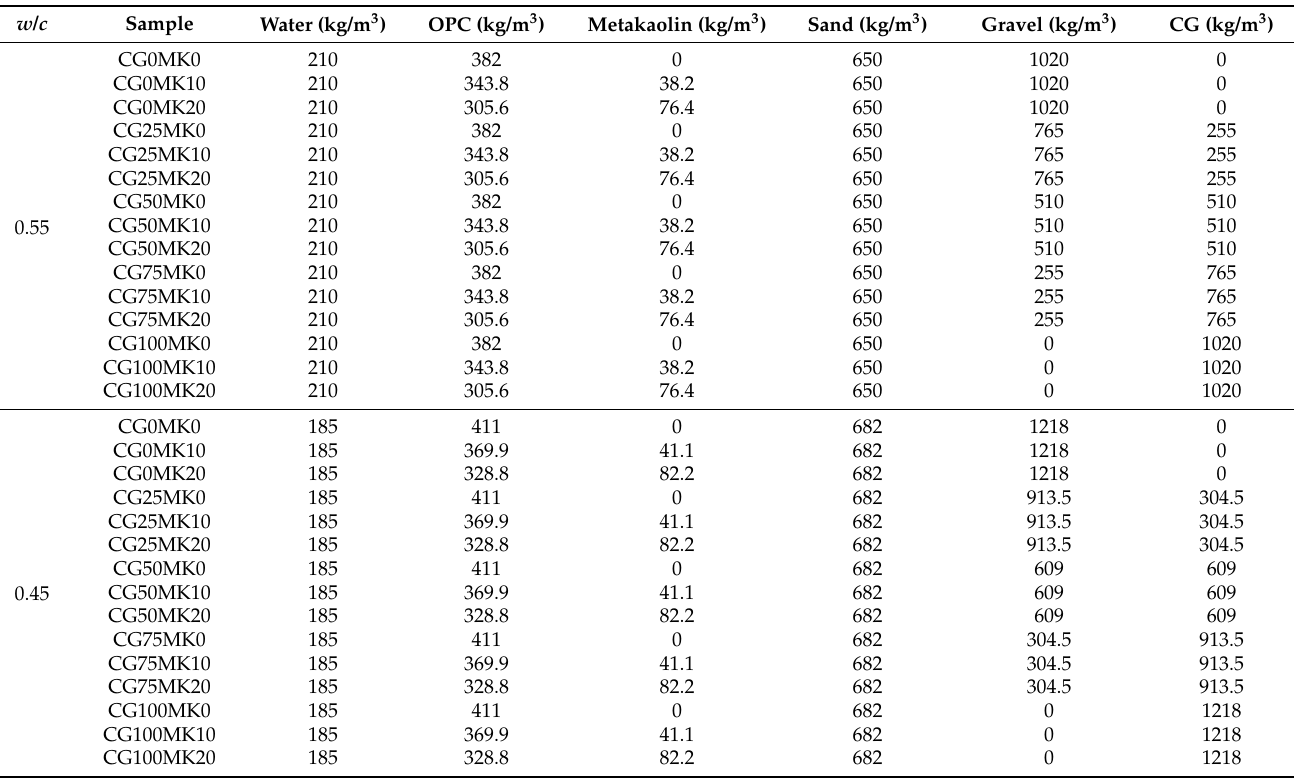
Table 2. The mix proportions of the concrete